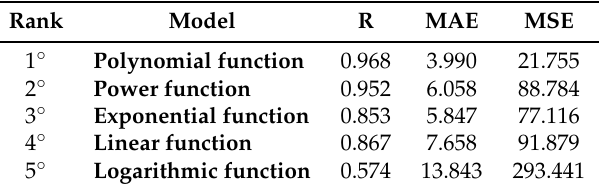
Table 7. Effective functions for forecasting production.